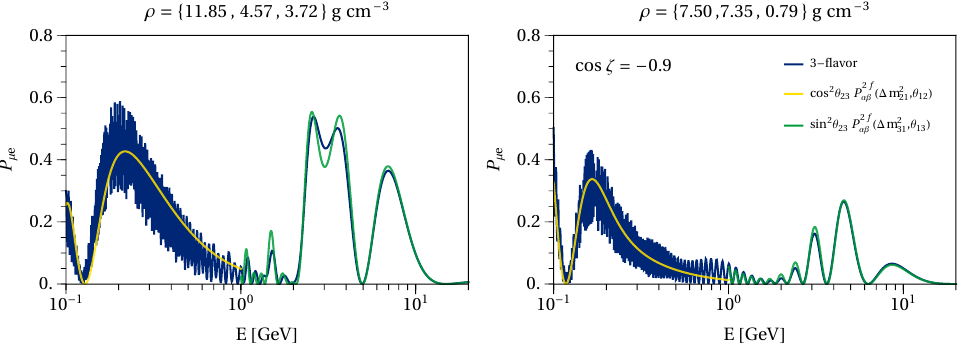
Figure 7 . Comparison of the full three-flavor appearance oscillation probability P µe (blue) with the solar (yellow) and atmospheric (green) approximation from eqs. (2.21) and (2.22),